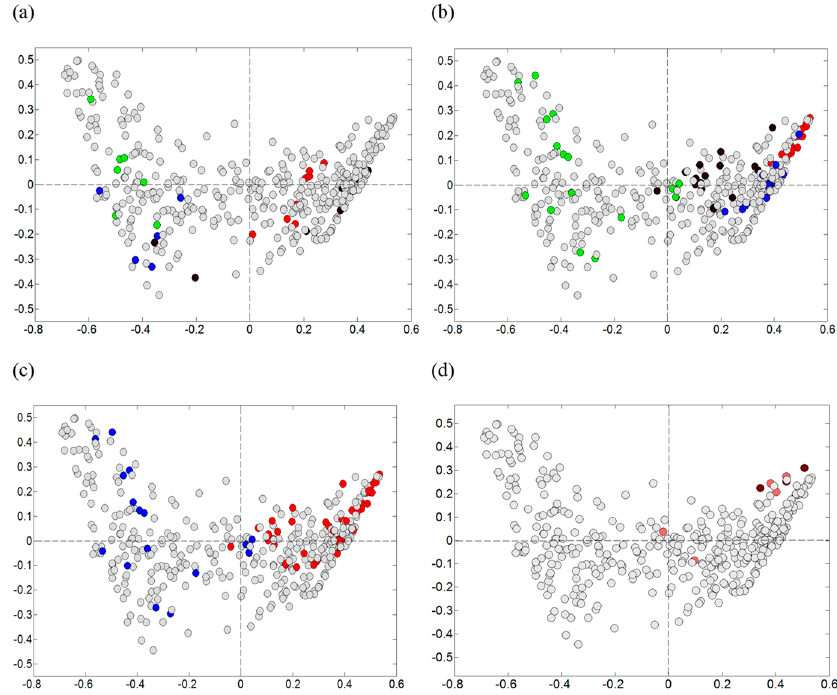
Figure 4. Visualization of early/late samples and salinity/ripening temperature. Showing the same PCA plot as in Figure 3, however visualizing by colors the mid-level samples from four of the producers (all other data-points are grey). Samples collected ( a ) early (days 0, 3, and 7) and ( b ) late (days 42, 63, and 91) during the rakfisk ripening from the producers; 1: green, 2: blue, 3: black, 4: red. ( c ) Blue: high salinity ( ≥ 5.8% NaCl) combined with low ripening temperature ( ≤ 4.5 ◦ C) (Producer1), red: low salinity ( ≤ 5% NaCl) combined with higher temperature ( ≥ 5 ◦ C) (Producers 2, 3, and 4). ( d ) Including data points from an additional experiment where Producer 1 prepared their regular fish using a lower salinity combined with a higher ripening temperature. Pale red; day 42 and 63, dark red: day 91. Table 3. The relative amount (% of selected bacteria compared to the total bacterial load) of Psychrobacter and Lactobacillus in samples collected early (days 0–7) and late (days